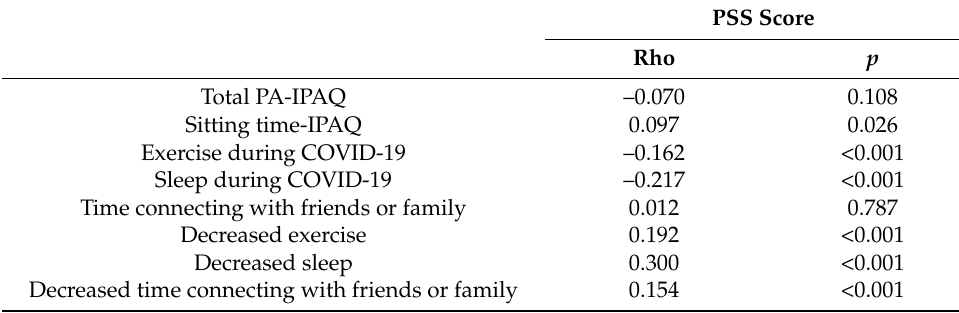
Table 3. Associations between stress and healthy lifestyle